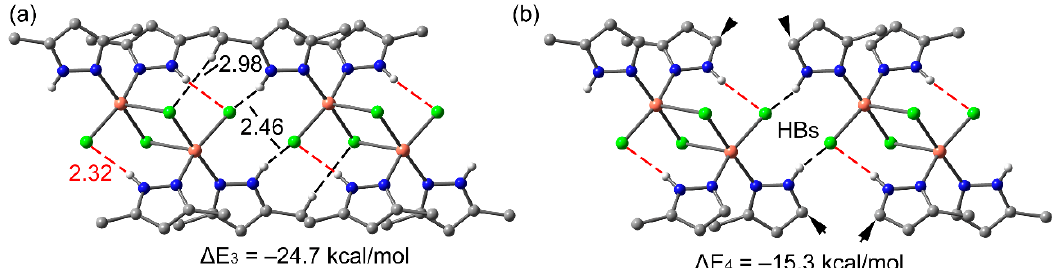
Figure 8. Complete ( a ) and mutated ( b ) theoretical models used to evaluate the N–H···Cl and C– H···Cl H bonds in compound 2 . The distances were measured in Å. The H atoms have been omitted for clarity, apart from those that formed H bonds.